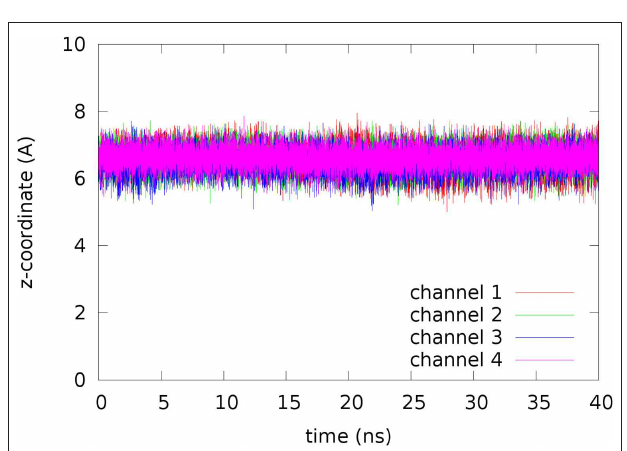
FIGURE 5 | Fluctuations of erythritol inside the channel. The coordinates represent the last 40 ns of the 120 ns MD